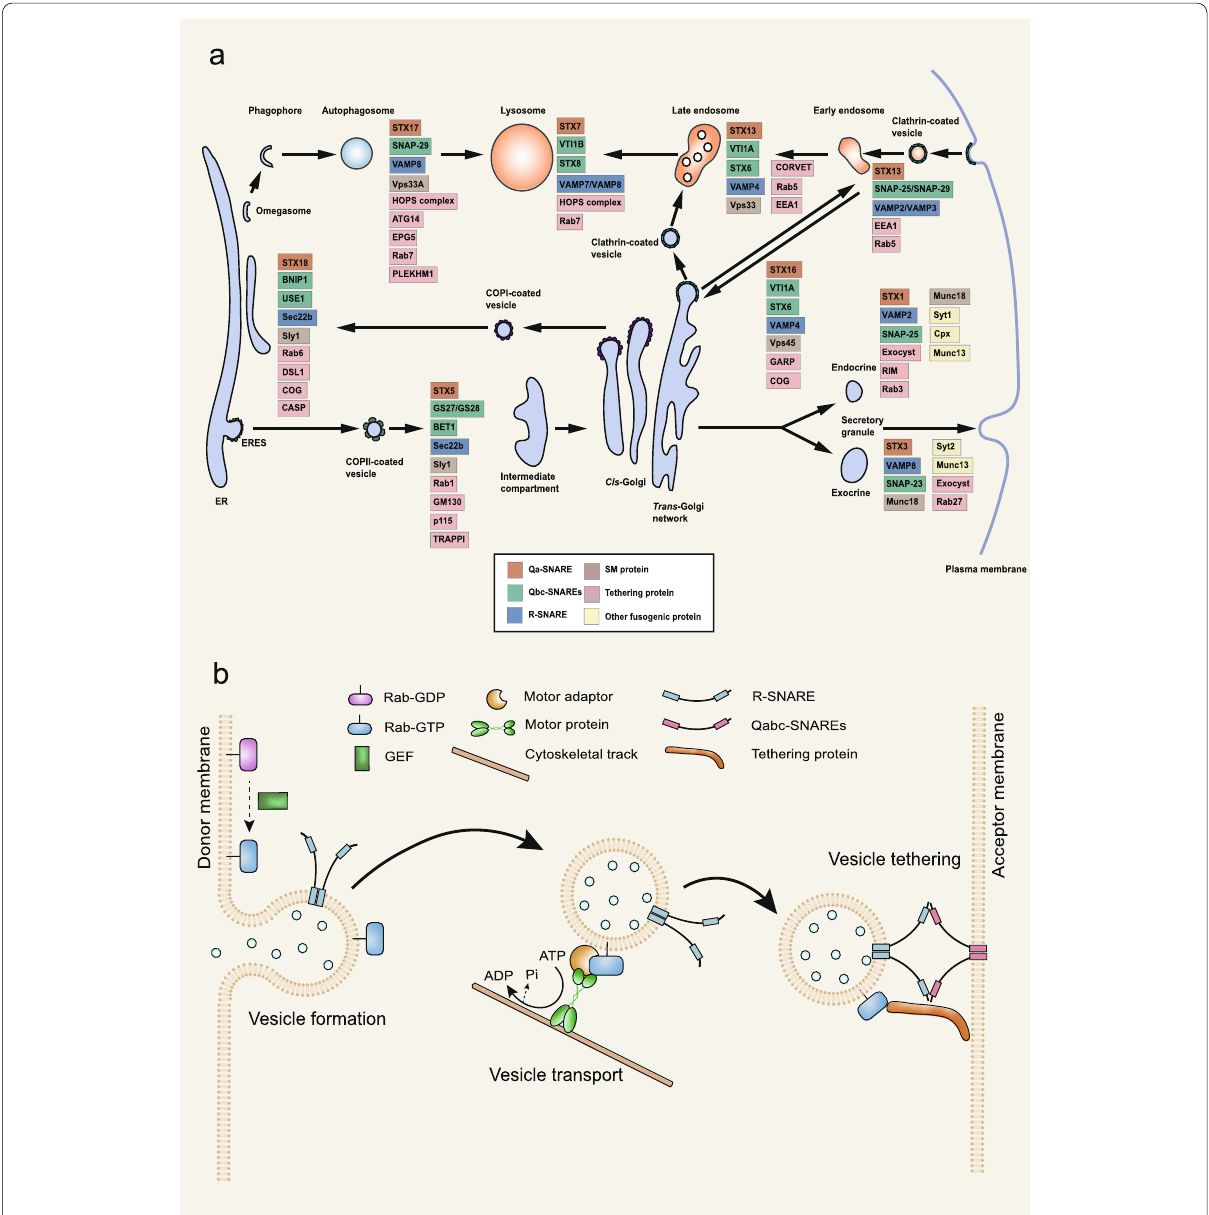
Fig. 2 Intracellular vesicle trafficking pathways. a The SNAREs, SM proteins, tethering proteins and other fusogenic proteins in intracellular vesicle trafficking pathways. In mammalian cells, intracellular vesicle trafficking includes the ER-to-Golgi transport, the retrograde Golgi-to-ER transport, the TGN transport, the endocytic pathway, the membrane trafficking in autophagy and others. Different SNAREs and fusogenic proteins are assigned to different vesicle trafficking pathways. (Red, Qa-SNARE family; Light green, Qbc-SNARE family; Blue, R-SNARE family; Brown, SM protein; Pink, Tethering protein; Yellow, other fusogenic protein). Vps45, Vacuolar protein sorting 45 homolog; GARP, Golgi-associated retrograde protein. b The working model of vesicle transport and tethering. Rab GTPases mediates vesicle transport along the cytoskeleton tracks (actin filaments or microtubules) by indirectly binding via motor adaptors or directly binding to motor proteins. After cargo containing vesicles being loaded, motor proteins drive vesicles moving along cytoskeleton tracks to the destination by hydrolysis of ATP. Afterwards, GTP-bound Rab recruits tethering proteins to dock vesicles with the acceptor membrane. The copyright permission of panels a and b are from [3,